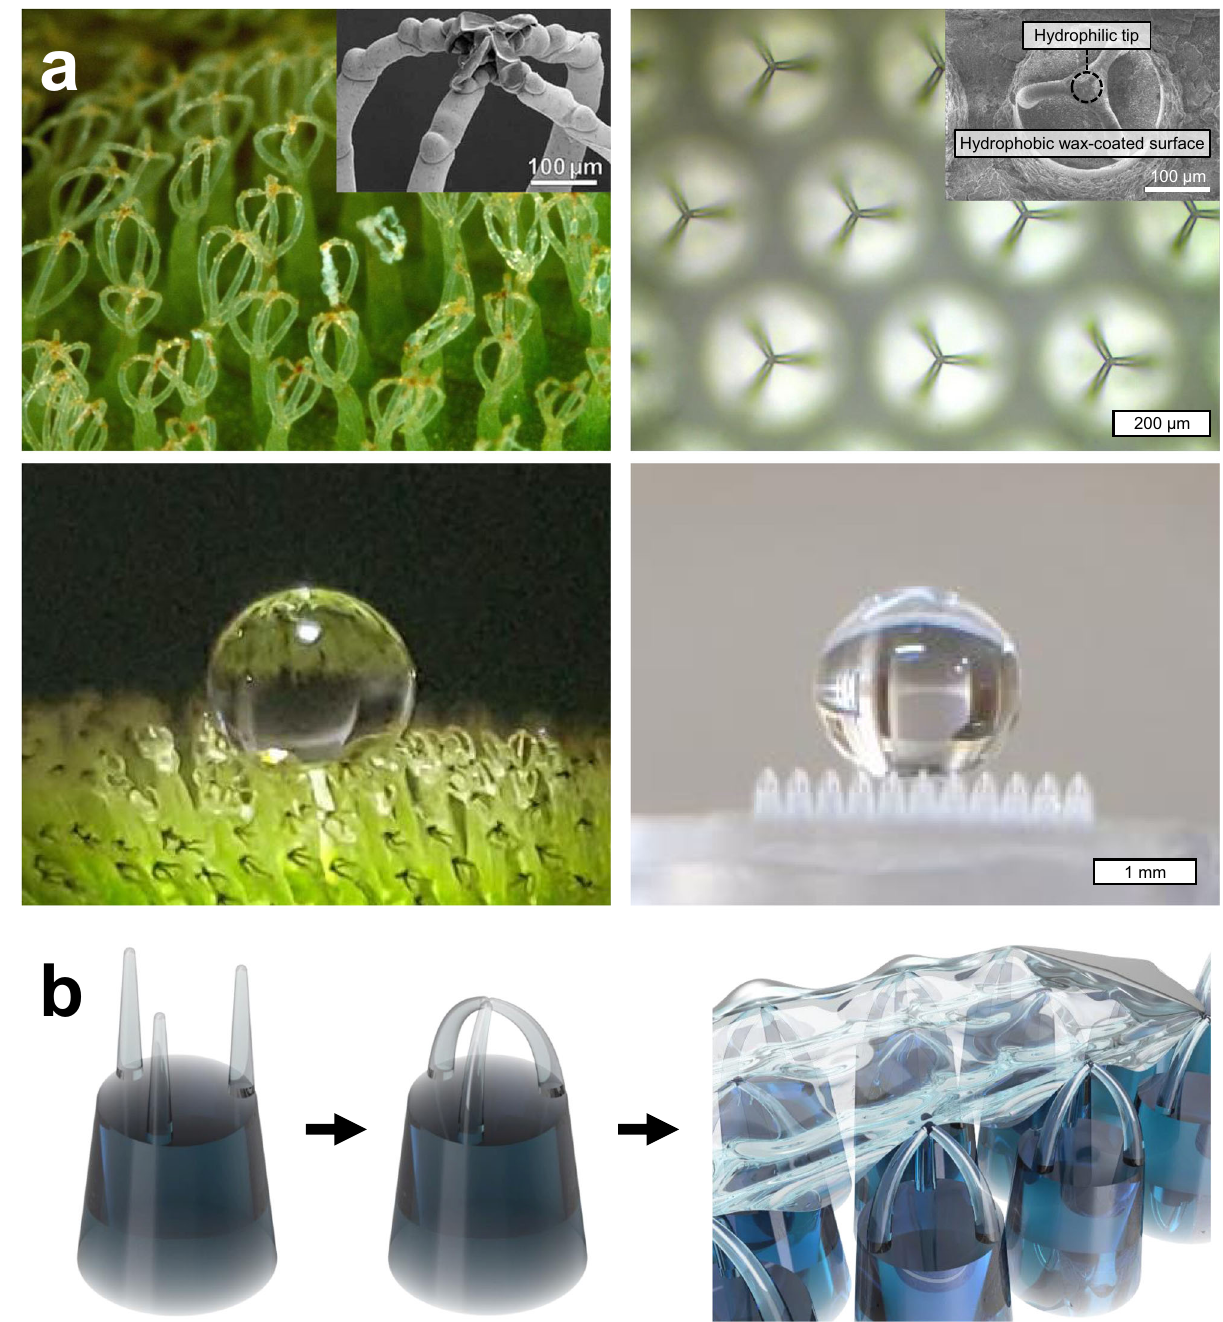
b Schematics showing the concept of the fabrication of Salvinia -inspired HDR